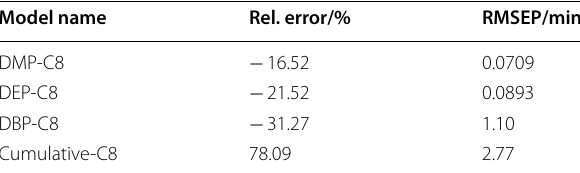
Table 2 Evaluation of the model’s training error